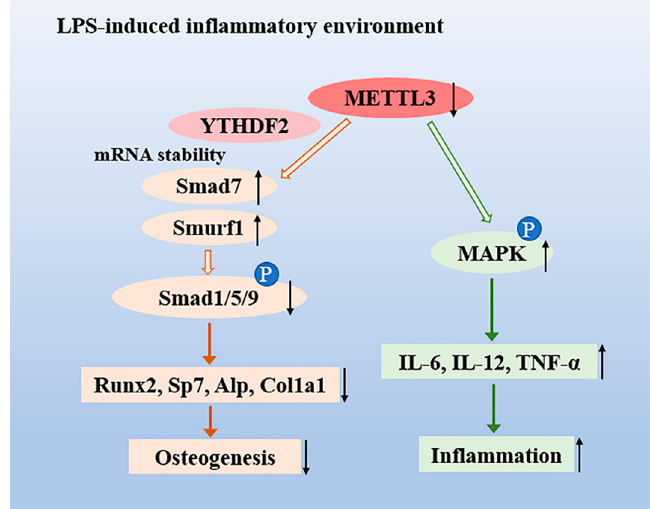
Figure 6. The role of the N6-adenosine methyltransferase METTL3 in an LPS-induced inflammatory model of osteoblasts. METTL3 suppression reduced the activation of Smad-dependent signaling by stabilizing the mRNA transcripts of Smad7 and Smurf1 via YTHDF2 involvement and inhibited osteoblast differentiation in an LPS-induced environment. Moreover, METTL3 depletion increased the expression of IL-6, IL-12, and TNF- α through activating MAPK signaling, thereby promoting the osteoblast inflammatory response.